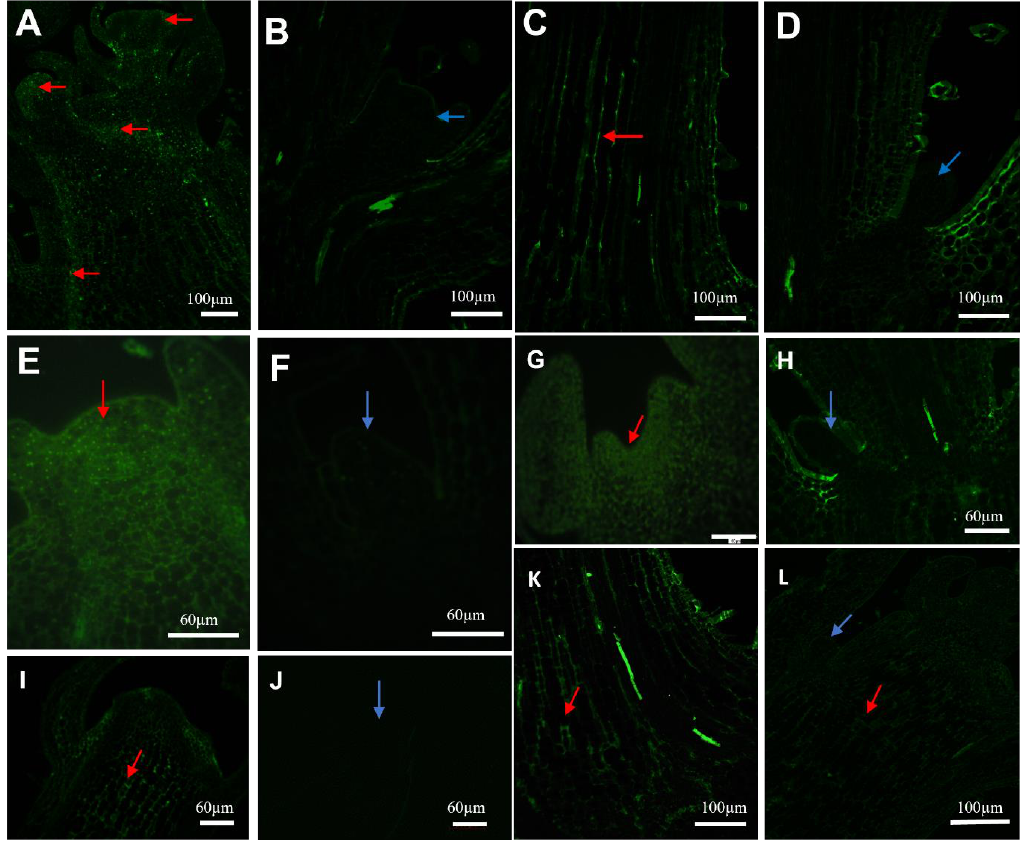
Figure 3. Auxin influx (LAX1 and AUX1) and efflux (PIN1) carriers immunoanalysis in stems of control ( A , B , E , F,I , J ) and stroked 160 times per day ( C , D , G , H , K , L ) plants. Red arrows present LAX1, AUX1, and PIN1 antibody signals in SAM buds and provascular strands of the main stem ( A , C , E , G , I , K ) and no signal (blue arrow) in the axillary bud ( B , D , F , H , J , L ).